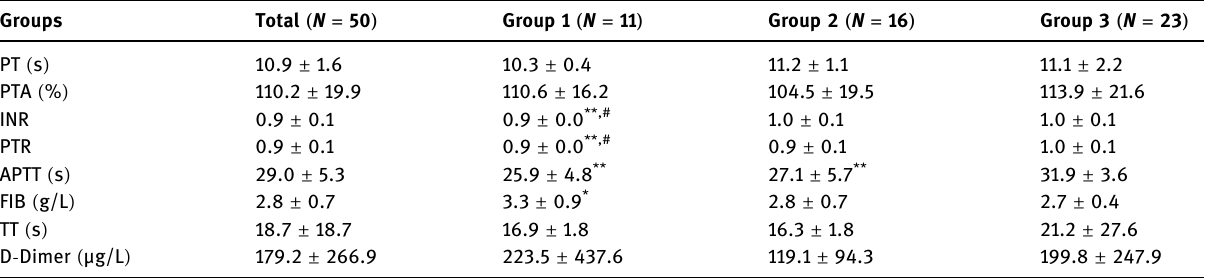
Table 6: Coagulation factors